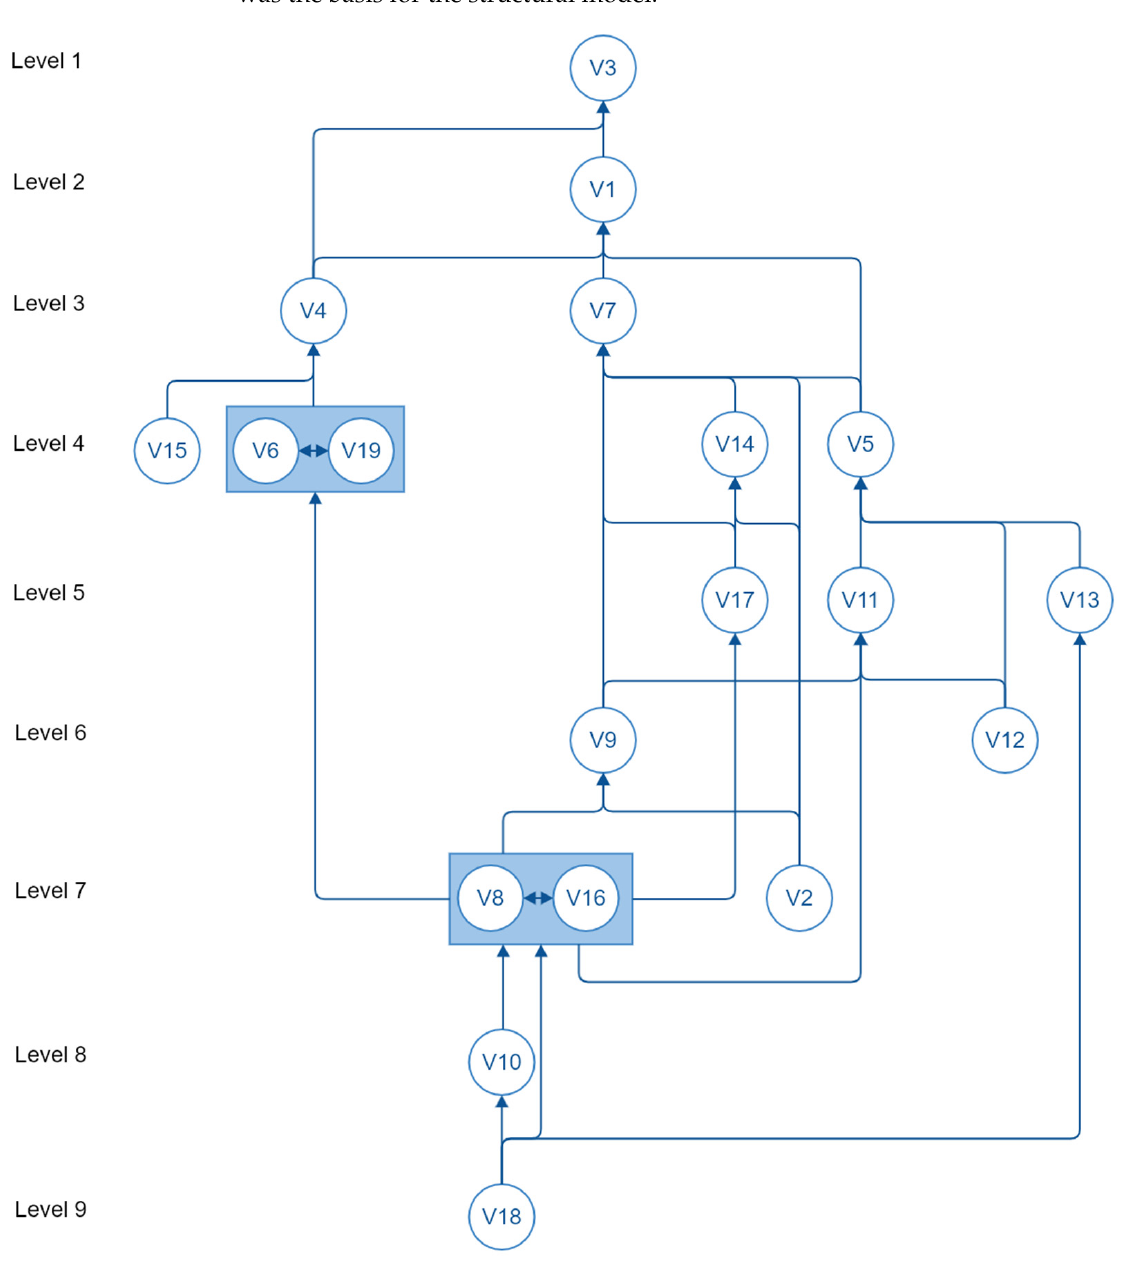
Figure 5. Digraph showing the relationships between the element set of vulnerability factors.